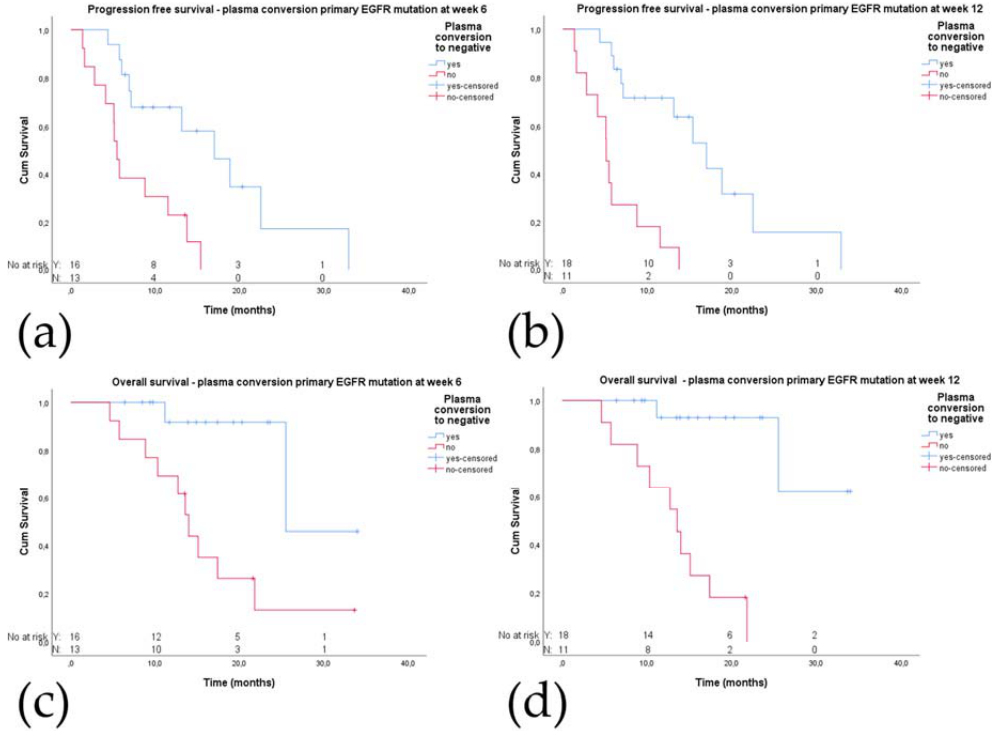
Figure 1. Plasma conversion of the primary epidermal growth factor receptor (EGFR) mutation in relation to progression-free survival (PFS) and overall survival (OS): ( a ) PFS and plasma conversion at week 6; ( b ) PFS and plasma conversion at week 12; ( c ) OS and plasma conversion at week 6; ( d ) OS and plasma conversion at week 12.